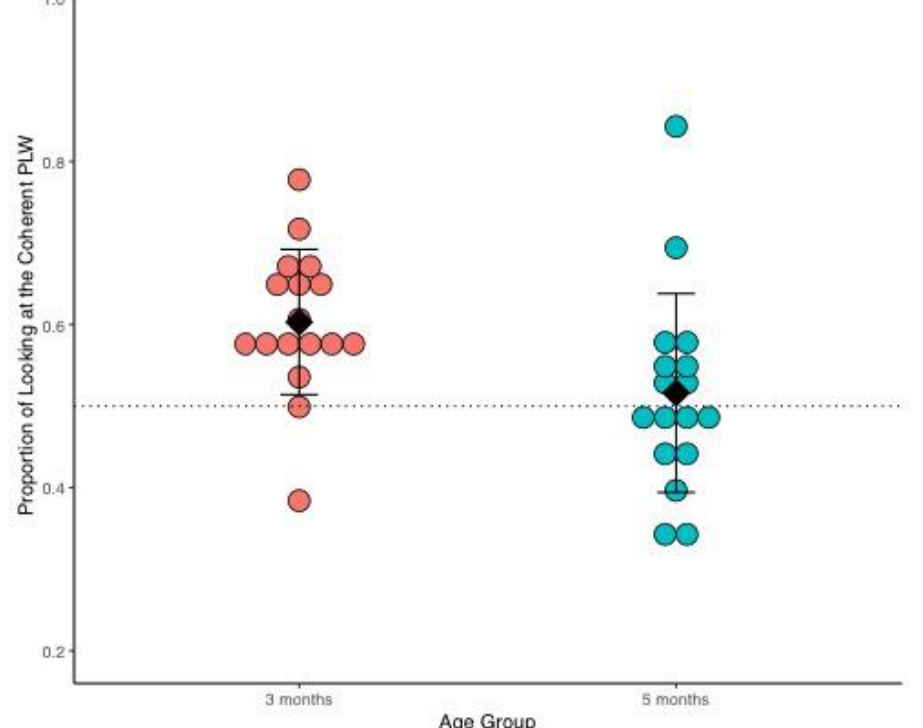
Figure 2. Proportion of looking at the coherent point-light walker (PLW) in Experiment 1 at three and five months of age. Each dot represents the proportion of looking at the coherent point-light walker for an individual subject. Three-month-old infants are denoted by orange dots ( n = 17), and blue dots denote five-month-old infants ( n = 17). Mean group proportion per age group is represented by the black diamonds and the black bars denote 1 +/− standard deviation of the mean. The doted horizontal line marks the 0.50 proportion, (i.e., equal looking at both stimuli) and no preference.